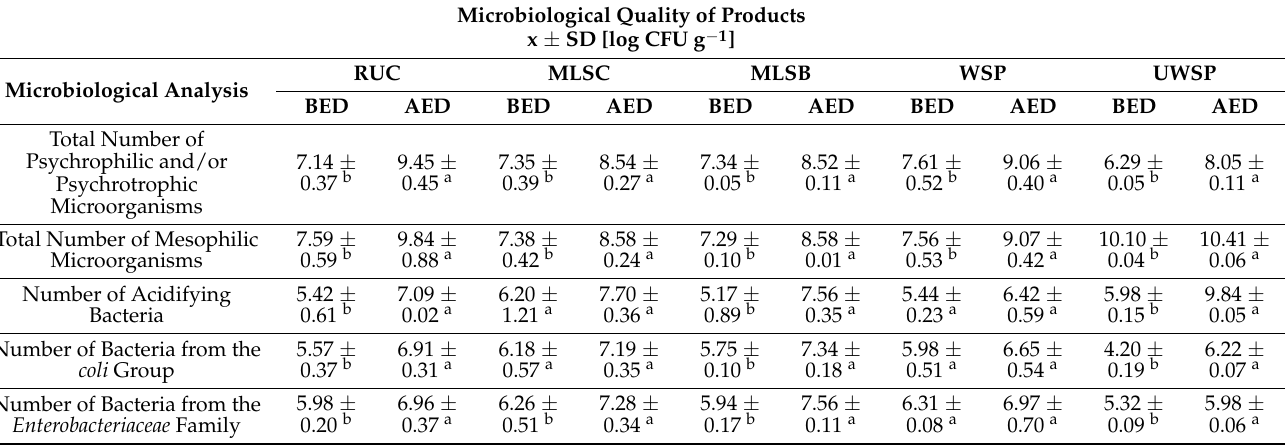
Table 1. Microbiological quality of the tested minimally processed plant-based food products during refrigerated